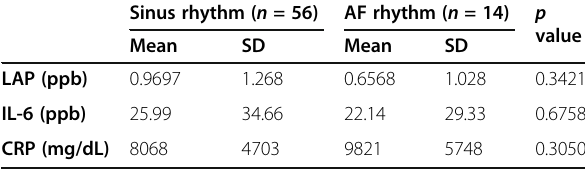
Table 5 Relation between rhythm and LAP, IL-6, and